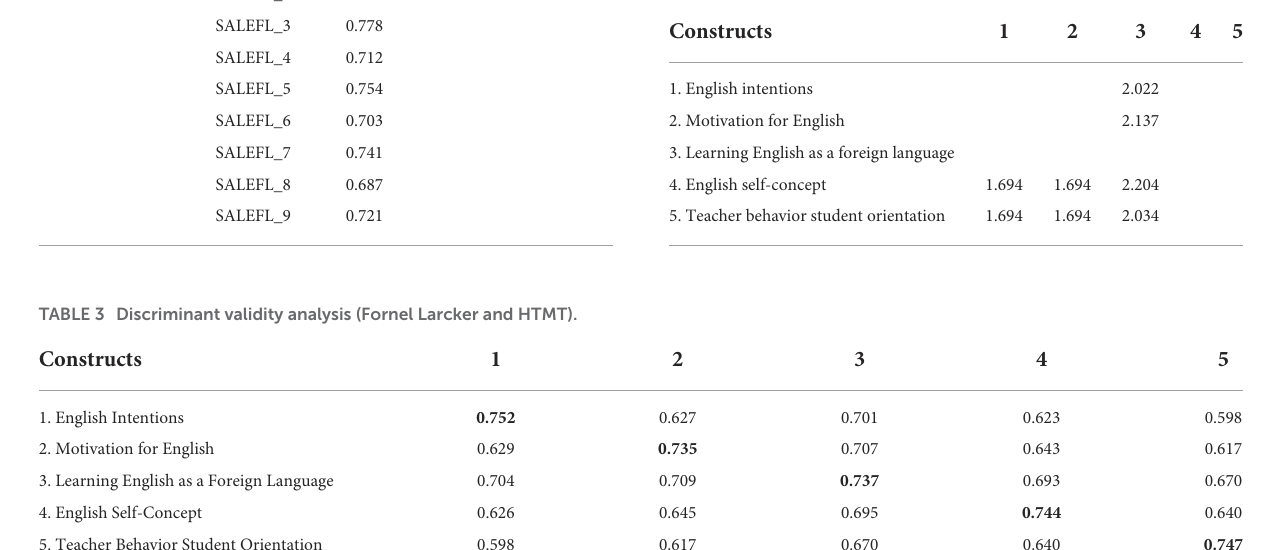
TABLE 4 Variance influence factor.